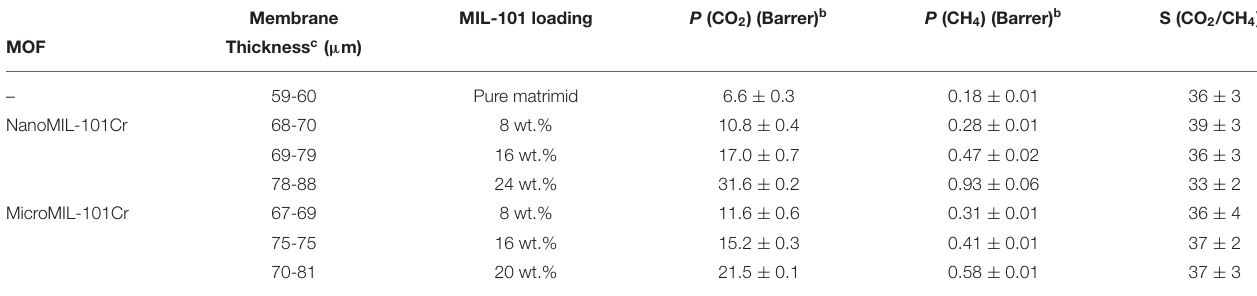
TABLE 3 | Summary of gas permeation properties of nanoMIL-101Cr@Matrimid and MIL-101Cr@Matrimid membranes for a 50:50 v:v gas mixture of CO 2 and CH 4 . a